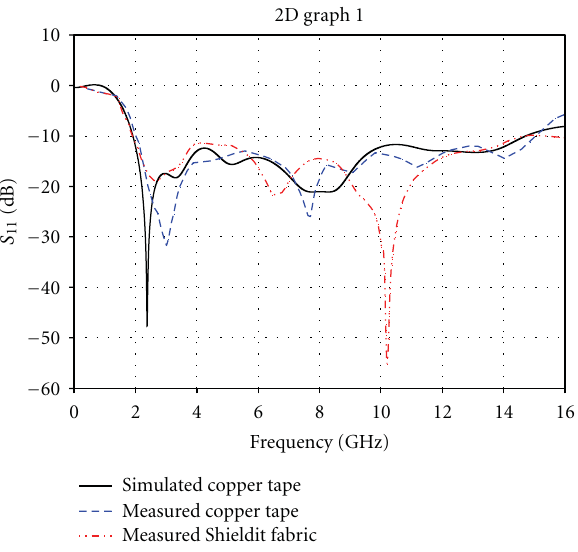
Figure 4: Comparison between simulated and measured ( | S 11 | ) results of the proposed wearable textile UWB antenna